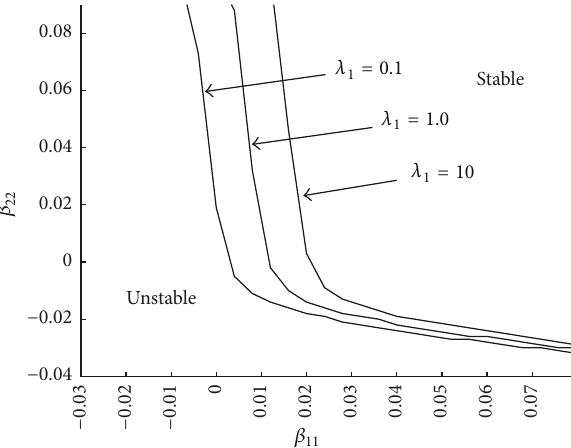
Figure4:Thestabilityboundariesinthe (𝛽 11 ,𝛽 22 ) planefordifferent transition rate 𝜆 1 when 𝜏 = 0.6